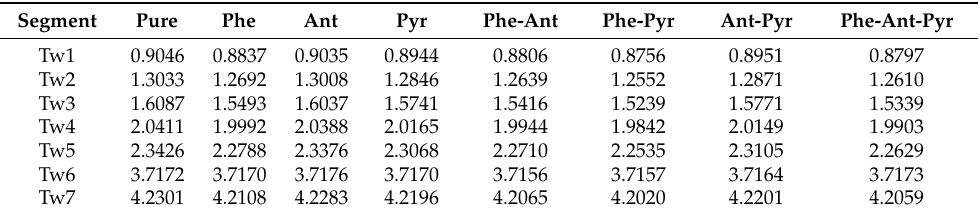
Table 2. Proton chemical shifts (ppm) for Tween 80 with and without the solubilization of different PAHs at the Tween 80 concentration of 50 mM.